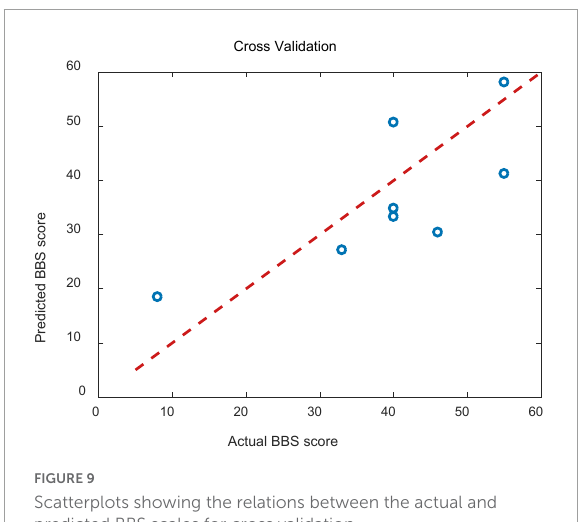
FIGURE9 Scatterplots showing the relations between the actual and predicted BBS scales for cross